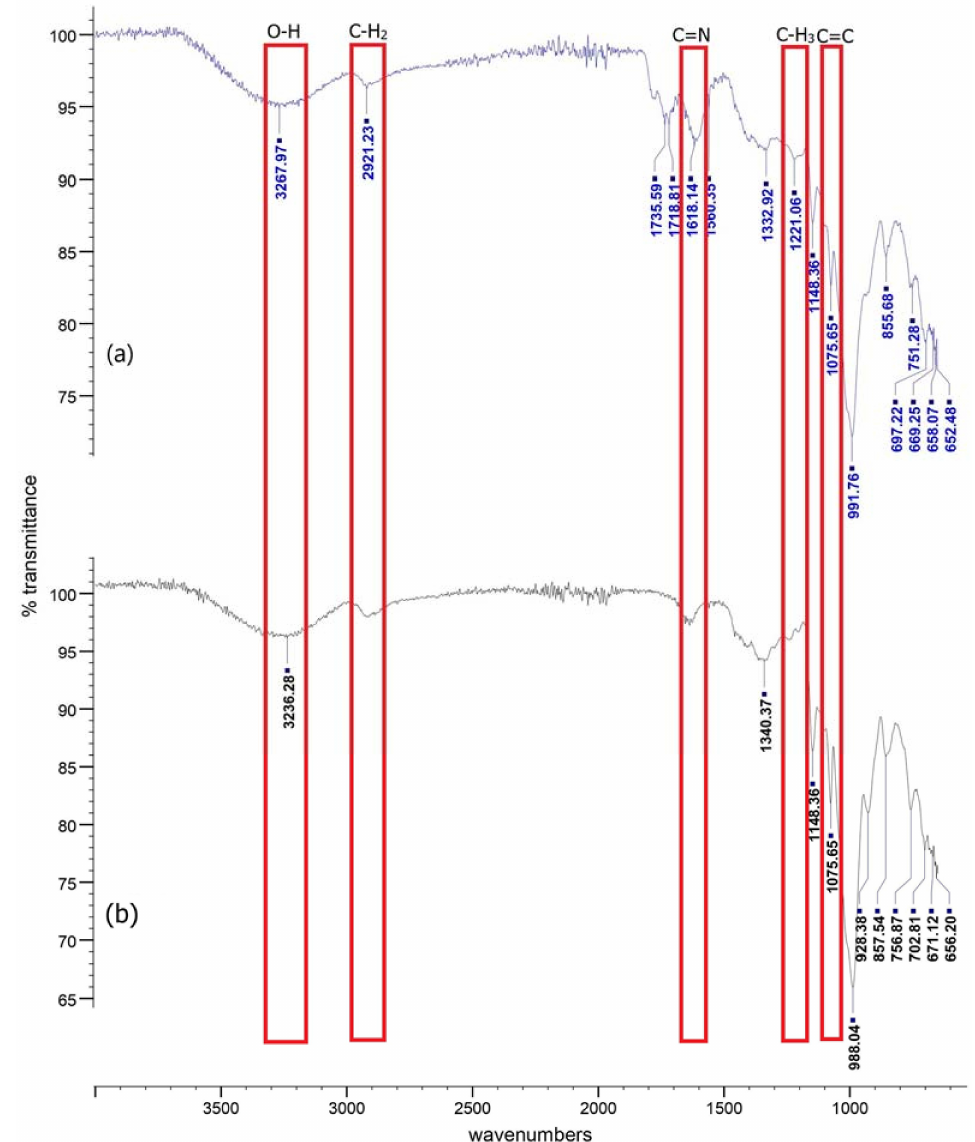
Figure 5. FT-IR spectra of developed films, ( a ) indicator film, ( b ) starch